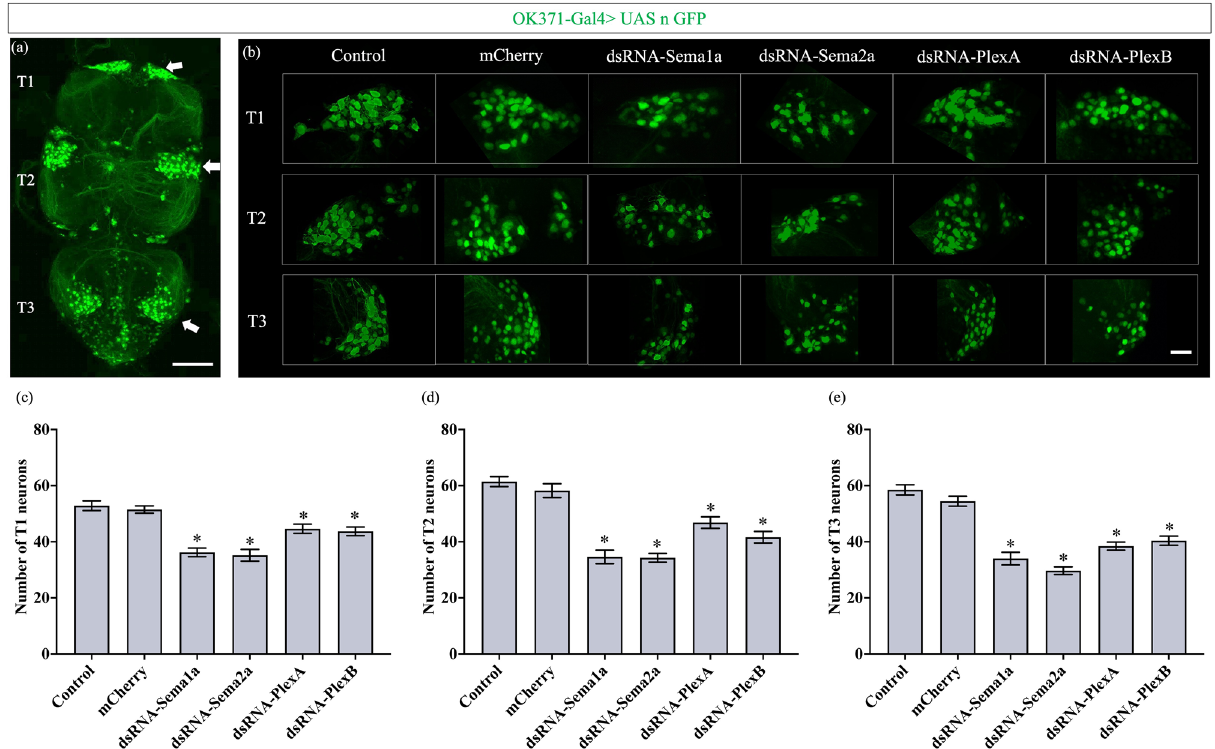
Figure 4. Knockdown of Semaphorins and Plexins results in motor neuron death. ( a ) Adult ventral nerve cord showing neuronal GFP expression driven by OK371-Gal4 . White arrows point to the location of leg motor neuron cell bodies in T1, T2, and T3 thoracic segments. The scale bar represents 100 µm. ( b ) Effect of glutamatergic knockdown of Semaphorins and Plexins (using OK371-Gal4 ) on adult leg motor neuron survival. A decrease in the number of leg motor neurons was observed after the knockdown of Semaphorins and Plexins genes. The scale bar represents 20 µm. ( c – e ) Quantification of adult leg motor neurons in T1, T2, and T3 respectively, following 9 days of axon guidance gene knockdown. Data shown are mean ± SEM (‘*’ denotes a significant difference from the control and mCherry; p < 0.05, one-way ANOVA and Tukey’s multiple comparison tests; n =